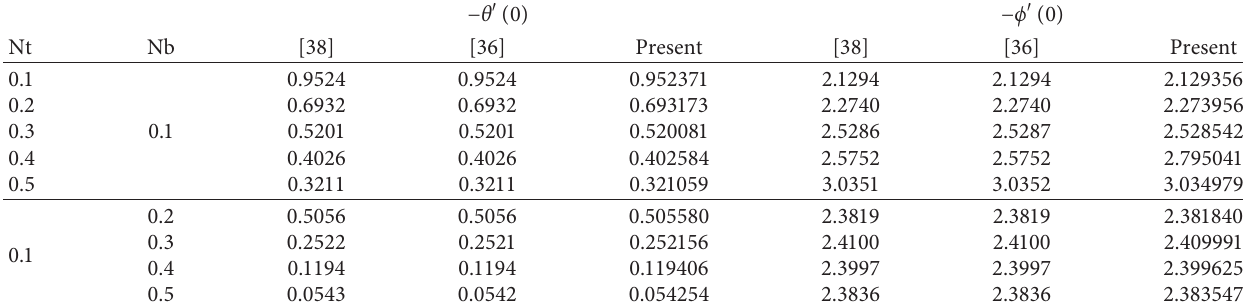
Table 1: Comparison of the presently computed values of − θ ′ ( 0 ) and − ϕ ′ ( 0 ) .